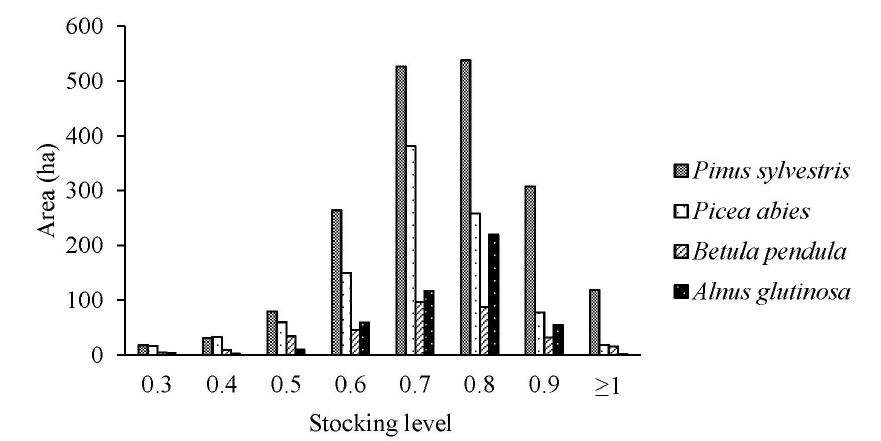
Figure 4. Distribution of Sambucus sp. in stocking level classes according different dominant tree species in the stand